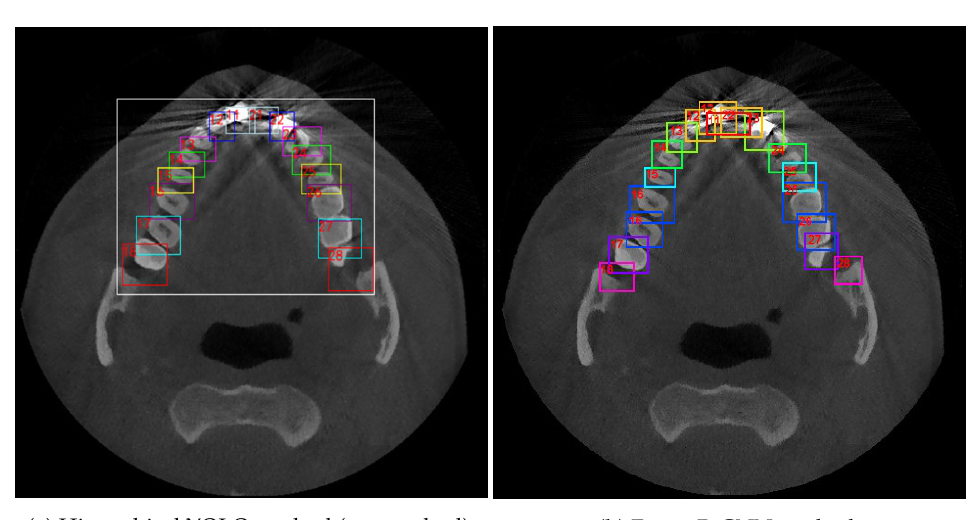
Figure 6. Visualization of the detection results on the severely noised image ( a ) hierarchical YOLO method deals with metal artefacts (tooth 11 and 22) and overlapping (tooth 28) well, ( b ) Faster R-CNN method makes a wrong and disordered detection on several similar teeth and metal